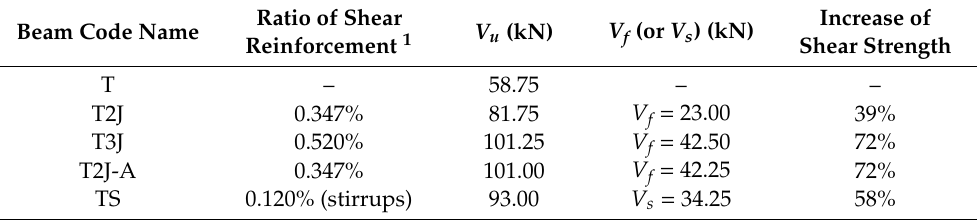
Table 2. E ff ect of FRP sheets on the shear strength.